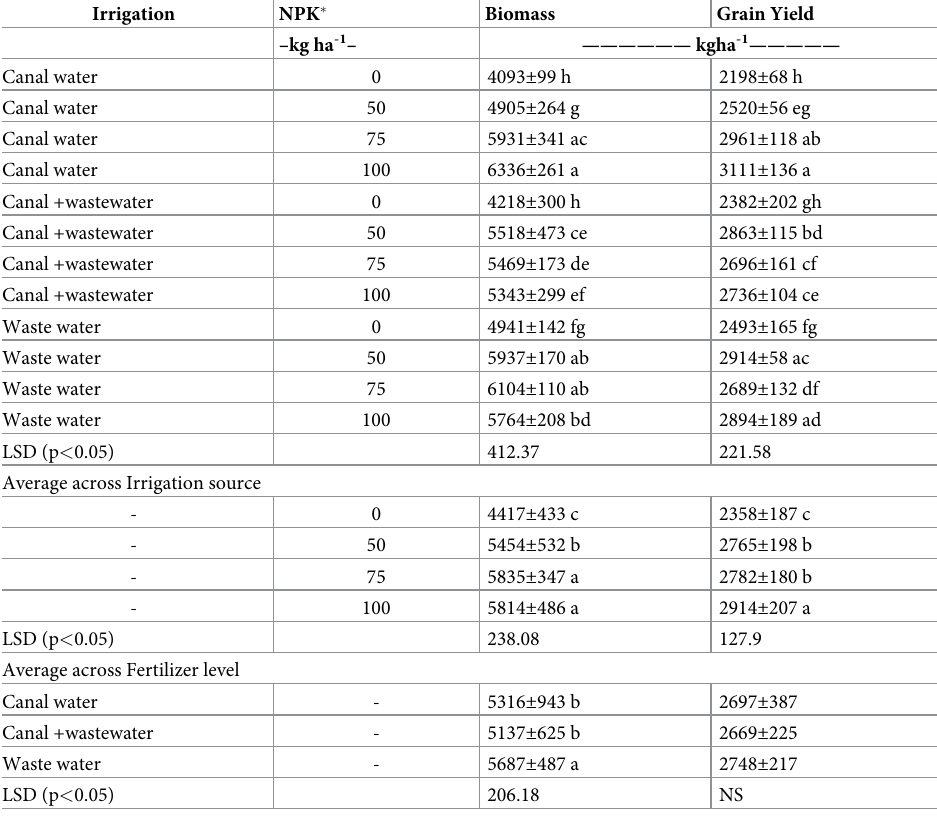
Table 3. Wheat biomass and yield as influenced by NPK level and irrigation source. Irrigation